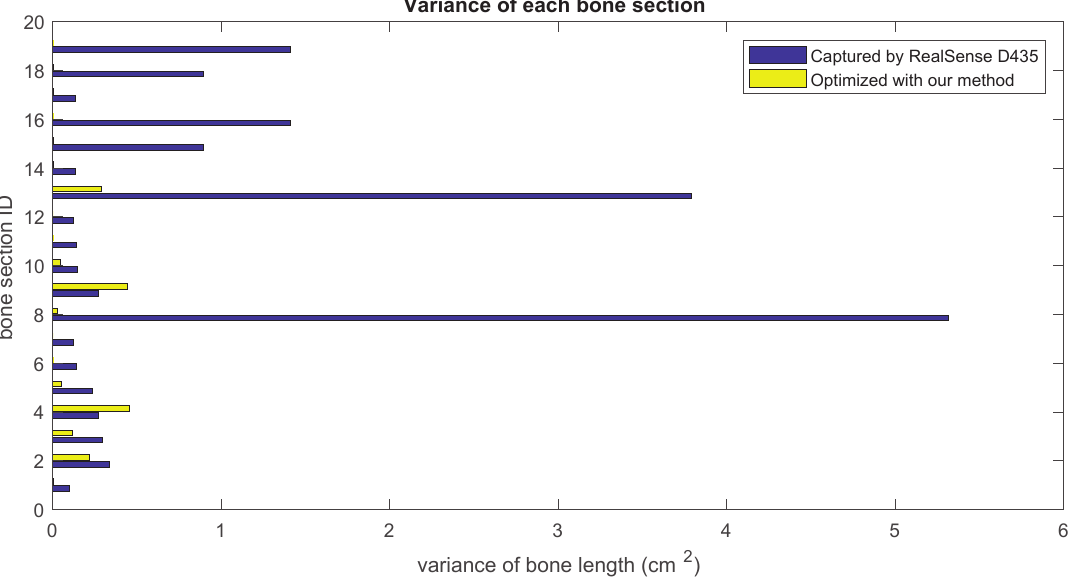
Figure 12. The summation of the bone length variance for each bone section over all frames. Purple: variance of the bone length captured with Nuitrack SDK for RealSense D435. Yellow: variance of the optimized bone length after applying our